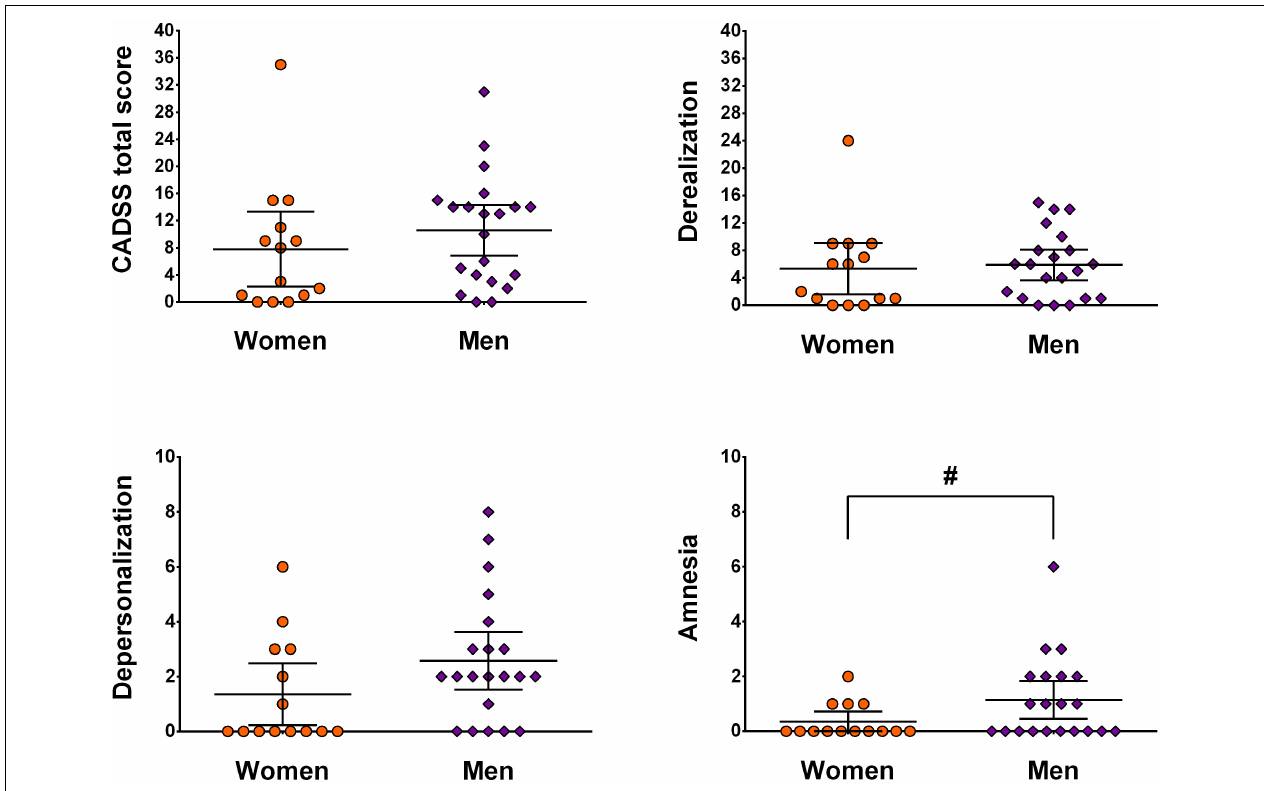
FIGURE 1 | Illustration of sex- and subscale-specific effects of ketamine. Data is presented as mean ± 95 CI and is not corrected for weight. # indicates p < 0.05.